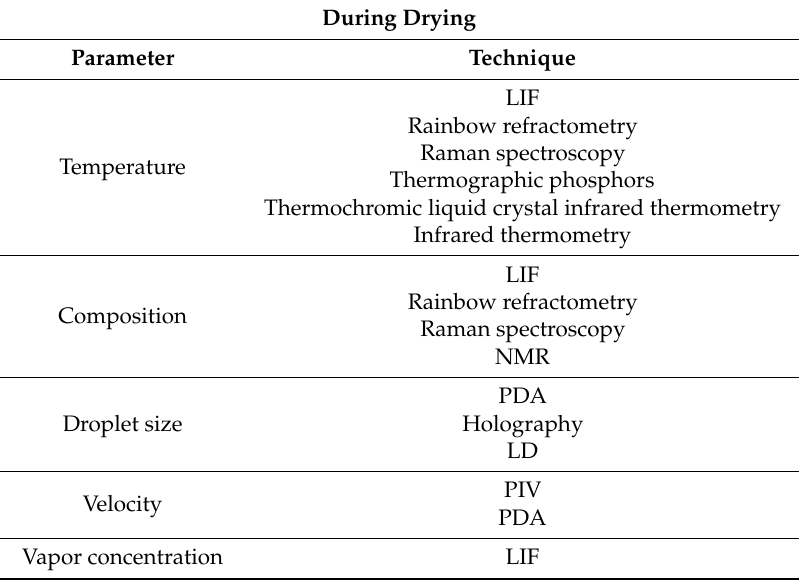
Table 2. Di ff erent drying parameters and droplet characterization